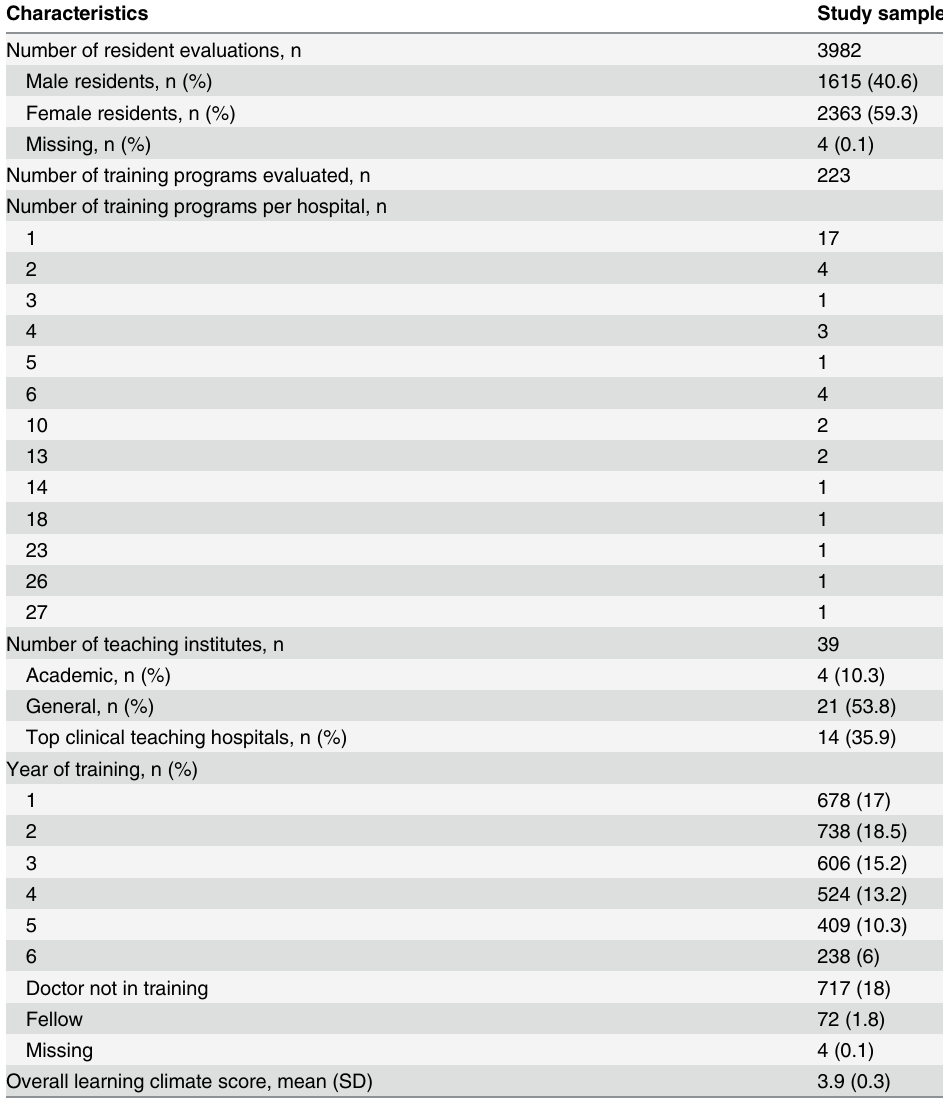
Table 1. Characteristics of the study